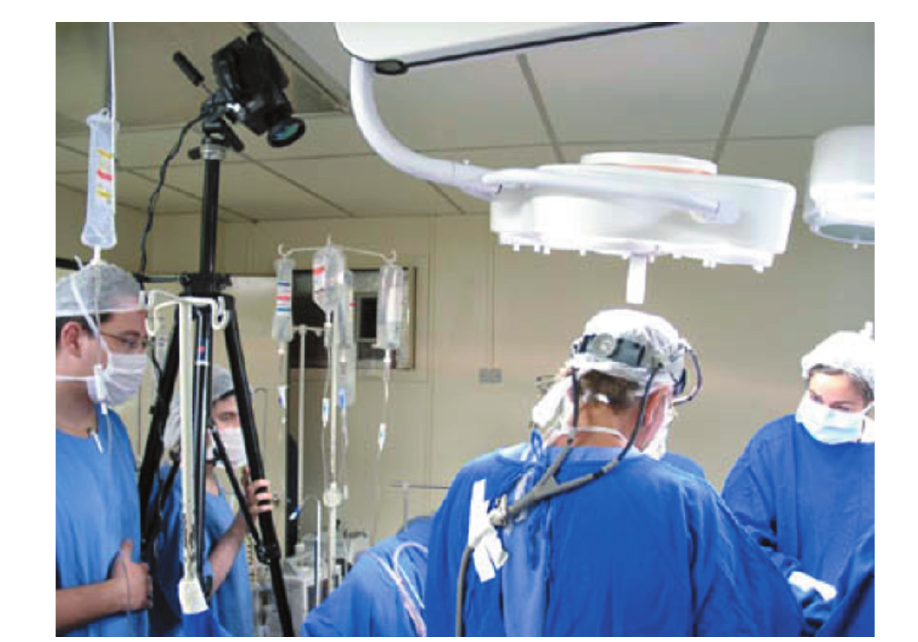
Fig. 1 Posicionamento da câmera infravermelha a uma distância de 1,3 metro do campo